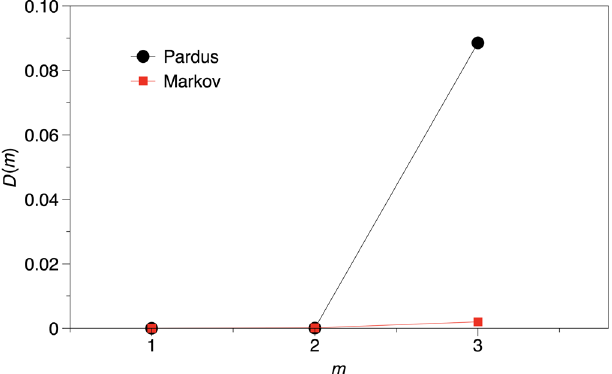
FIG. 5. Multiplexity detection statistic D ð m Þ , applied to ex- perimental mobility trajectories on the Pardus universe [75]. We find D ð 3 Þ > 0 , which suggests that mobility series are non- Markovian, in agreement with independent evidence